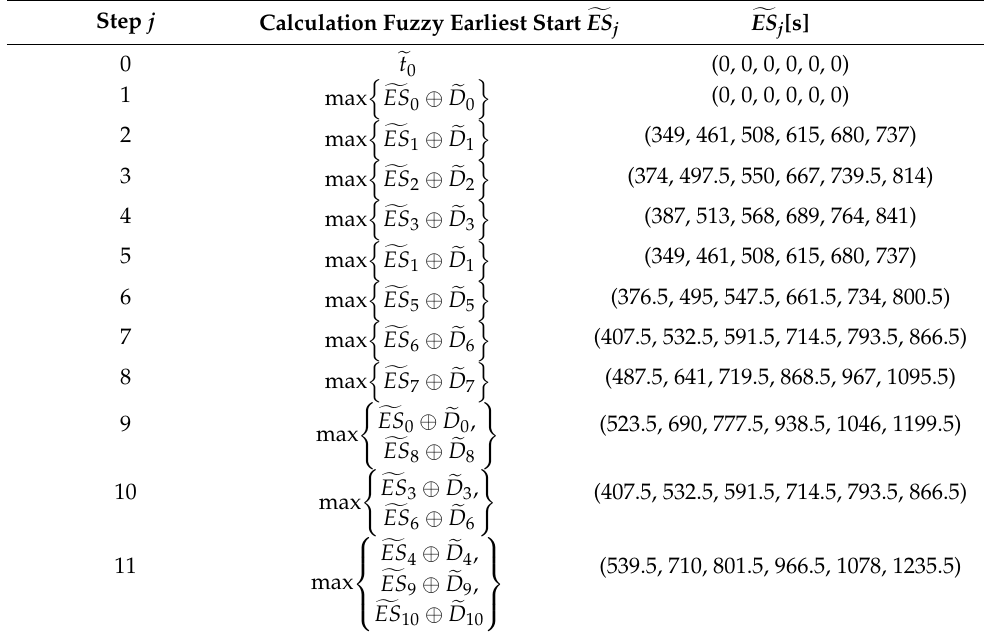
Table A2. Fuzzy earliest start ( (cid:102) ES j ) of disassembly steps.